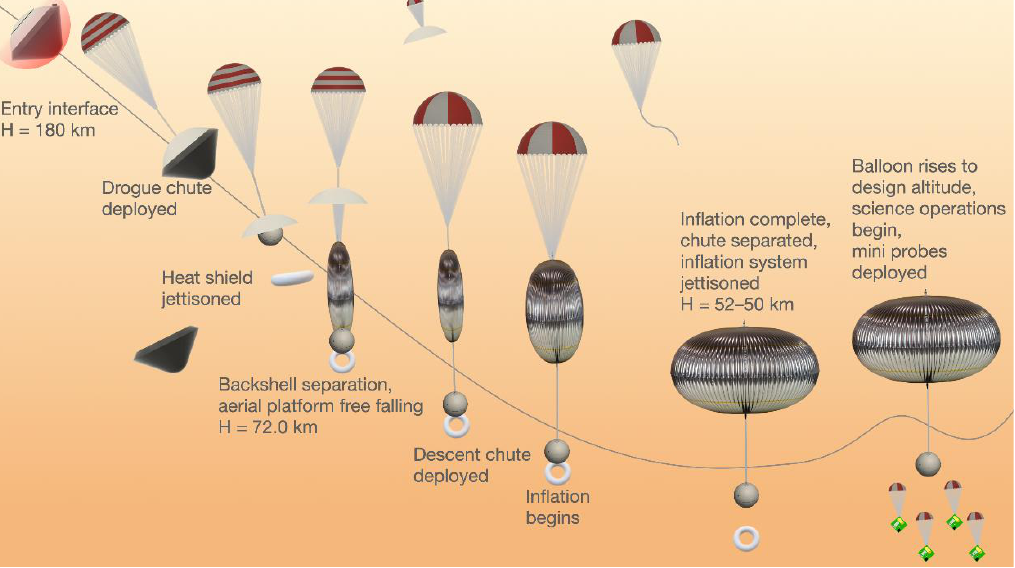
Figure 1. Entry, descent, and balloon deployment and operation sequence for a fixed-altitude balloon and mini probes. Not to scale. Figure modified from [48].